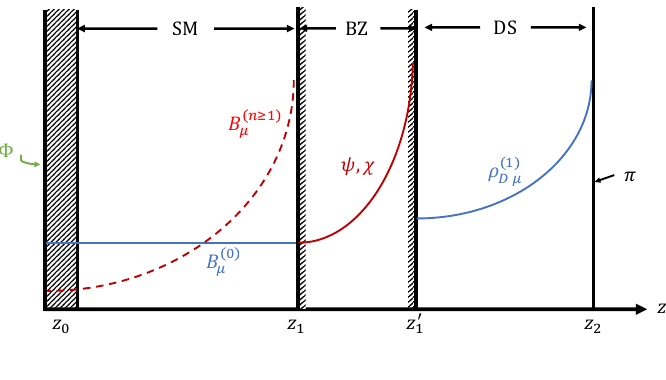
Figure 8 . AdS 5 picture leading to a small portal coupling λ appearing in 4d CFT picture. An extra bulk (called BZ-bulk) is introduced between the SM and DS bulk. The interactions between the BZ- bulk fields with SM and DS states generate desired suppression in the effective coupling between the SM and DS. The inflaton sector is simplified to a thin-brane picture. π represents the DM state(s). kinetic mixing with ρ µ . Since CFT is purely composite, its interaction with the external D B field B needs to be through its coupling to a composite state, ρ µ , which then mixes µ B with B . The composite-elementary mixing is O ( g/g ) , where g ( g ) is the µ 1 s 1 s